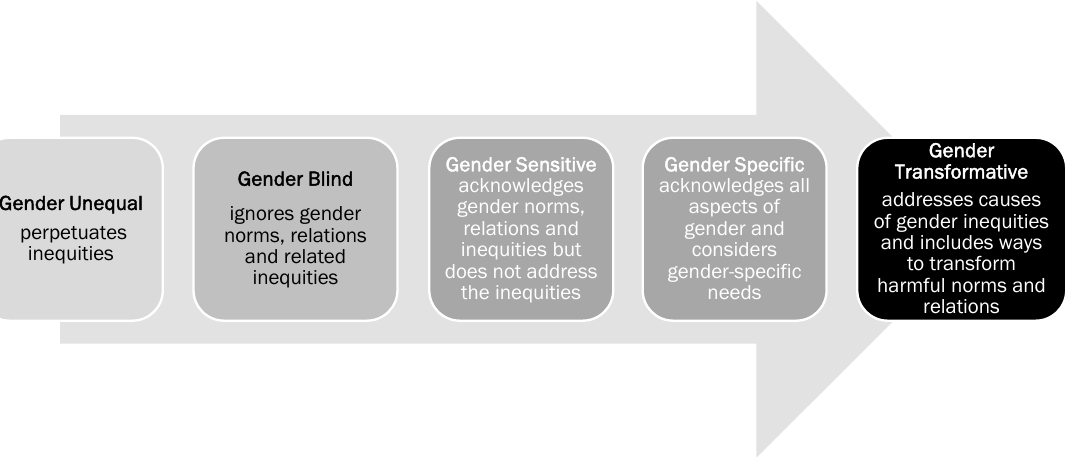
Figure 1. Gender Integration Continuum, reproduced adaptation with permission from Greaves, L., Pederson, A., Poole, N., Making it Better: Gender Transformative Health Promotion; published by Women’s Press, 2014 [14] (p. 22).